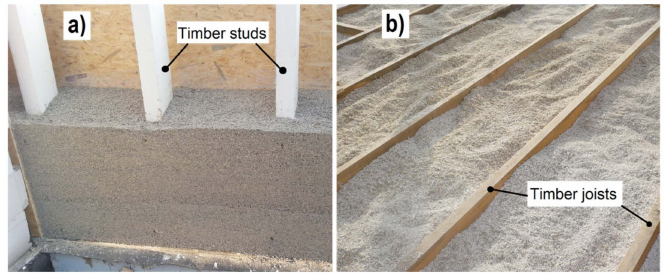
Figure 1. A timber frame wall ( a ) and floor of the joist construction ( b ) filled with a hemp–lime